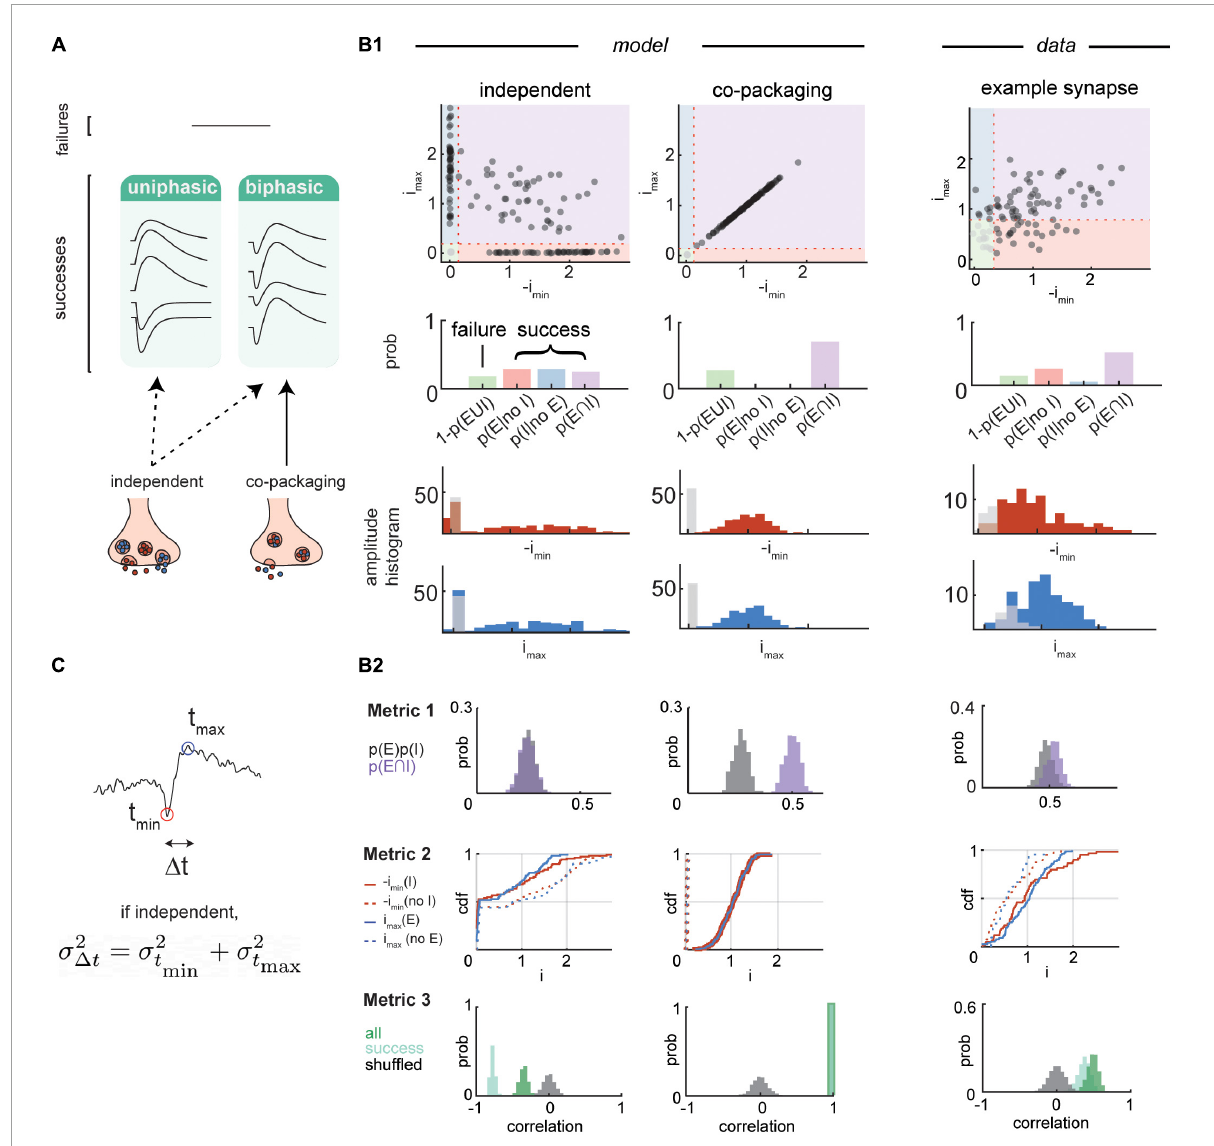
FIGURE2 Single vesicle post-synaptic current dynamics analysis. (A) Classifications of simulated post-synaptic currents (PSCs) under a low noise condition. First, individual trials of PSCs can be sorted into failure and success modes. Next, individual success trials of PSCs can be categorized to either biphasic or uniphasic modes. Neurotransmitter co-release by segregated vesicles predicts heterogeneity of the PSCs, containing both uniphasic and biphasic events. Co-release by co-packaging vesicles predicts presence of only biphasic success events. (B1,B2) Three statistical metrics for distinguishing co-release models and their application to experimental data analysis. Data adapted from Kim et al. (2022). (B1) Top, scatterplots of the maximum and minimum amplitudes of simulated PSCs (200 trials) from independent (left) and co-packaging (middle) release models compared to that of an example synapse (98 trials) (right). Amplitudes are normalized to the average maximum ( y -axis) and minimum ( x -axis) amplitudes of success trials. Middle, bar graphs of probabilities of trials with failures of both PSCs (green), success of excitatory PSC (EPSC) only (pink), success of inhibitory PSC (IPSC) only (blue), and success of both PSCs (purple). Bottom, histograms of the maximum (blue) and minimum (red) amplitudes with success of release and failures of release (gray). (B2) Analysis of the three metrics are compared between simulated dataset from independent (left) and co-packaging (middle) release models and an example synapse dataset (right). Top, Metric 1 determines if glutamate and GABA currents occur in individual trials more frequently than that expected by chance. Bootstrapped probability of presence of both EPSCs and IPSCs (purple) and multiples of individual EPSC and IPSC probabilities (gray) are shown. Middle, Metric 2 determines whether conditions of presence of absence of one current influence the distribution of the other current. Cumulative distribution functions of IPSC amplitude (i max , blue) conditional on the presence [i max (E), solid] or the absence [i max (no E), dashed] of EPSC. Similar analyses were performed on the EPSC amplitude [i min , red; i min (I), solid; i min (no I), dashed]. Bottom, Metric 3 determines if glutamate and GABA current amplitudes are correlated trial-by-trial. Bootstrapped correlation of a pair of EPSC and IPSC amplitudes for all trials (dark green), success trials (light green), and all trials with pairing order shuffled (gray). (C) Temporal variance of biphasic PSCs. Minimum (red dot) and maximum (blue dot) amplitude peaks were extracted from the analysis time window and their timings are indicated by t min and t max , respectively. (cid:49) t is the time difference between t min and t max within a